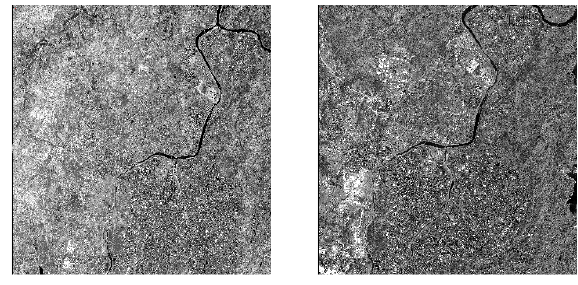
Figure 3. KOMPSAT-2 stereo pair over Daejeon, Korea Table 3. The properties of the used KOMPSAT-2 stereo